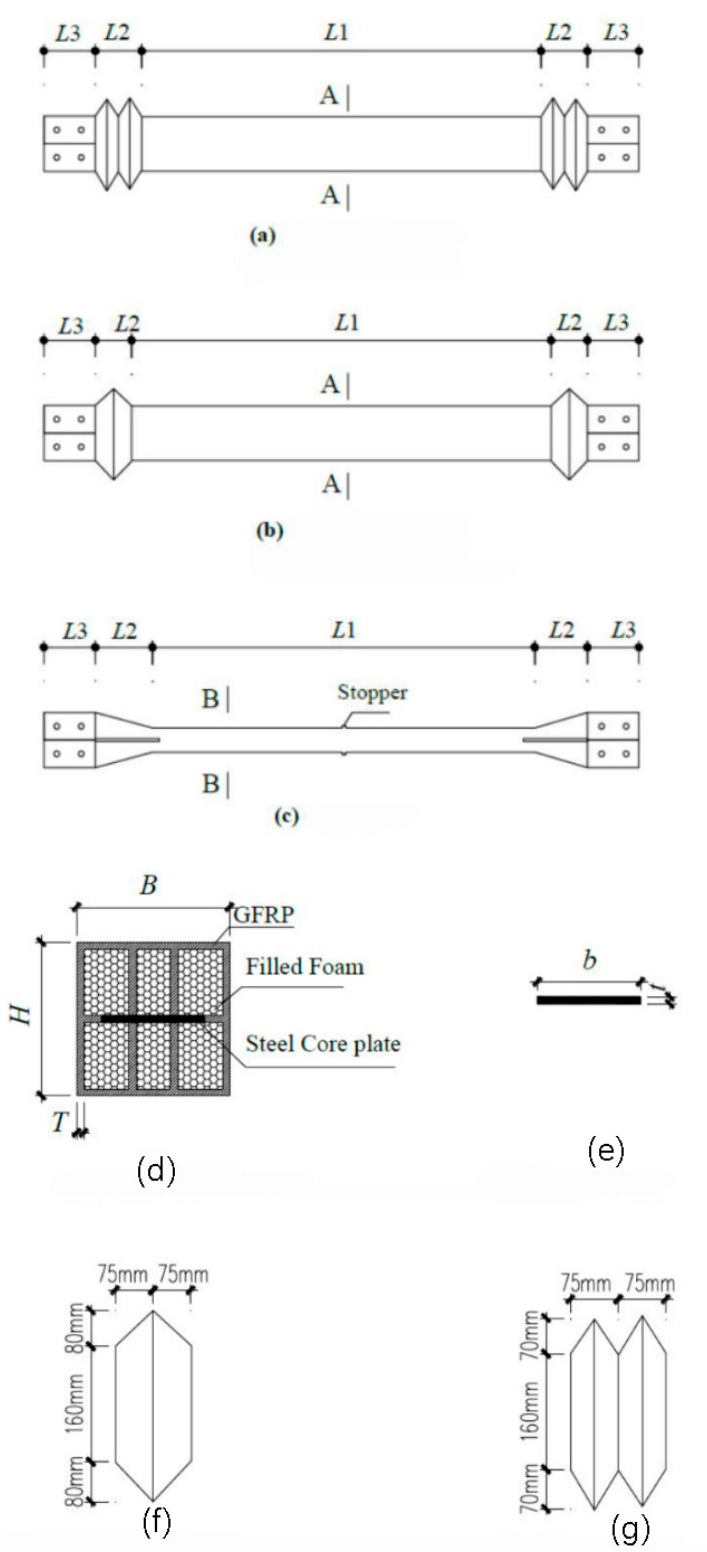
Figure 3. Details of the MFSC-BRB. ( a ) Plan view of BRB (double wave section); ( b ) Plan view of BRB (single wave section); ( c ) Core plate; ( d ) Section A-A; ( e ) Section B-B; ( f ) Single wave section; ( g ) Double wave